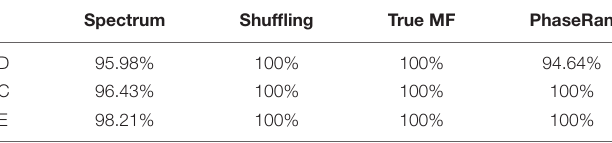
TABLE 3 | Testing results for true multifractality.